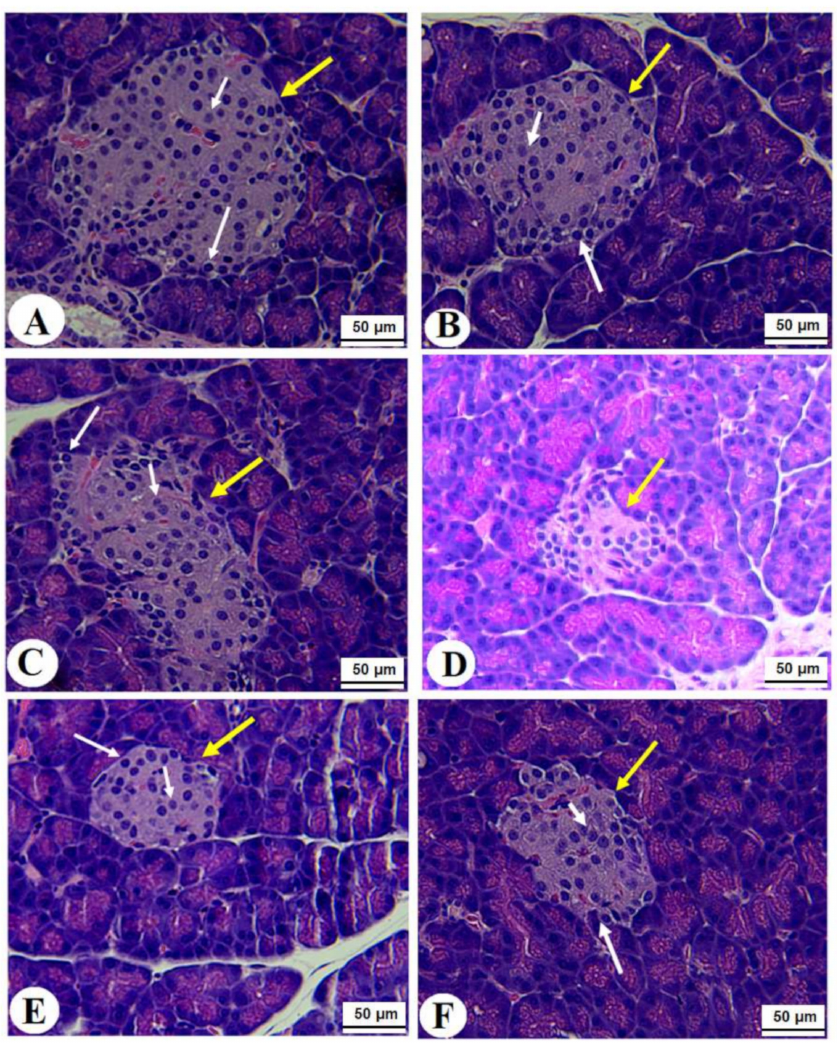
Figure 5. Photomicrographs of the pancreases from all groups of rats ( A – C ): Images taken from control, Fenugreek seed aqueous extract (FS-AE), and Fenugreek seeds galactomannan (F-GAL)- treated rats and showing normal structures of the islets of Langerhans (yellow arrow), which appear circular and of large size. The exocrine ( α )-cells were located at the periphery and normally had small cells with dark nuclei (long white arrow), whereas the endocrine β -cells (short white arrow) are located centrally with larger with light nuclei. ( D ): Photomicrographs taken from a streptozo- tocin (STZ)-diabetic rats in which the islets of Langerhans appeared smaller (yellow arrow) with a severe reduction in the number of the α and β -cells (long and short white arrows, respectively). ( E , F ): represents STZ + GCS-AE and STZ + F-GAL treated rats, respectively, and shows an increase in the size of the islet of the Langerhans and the number of α (long white arrow) and β -cells β -cells (short white